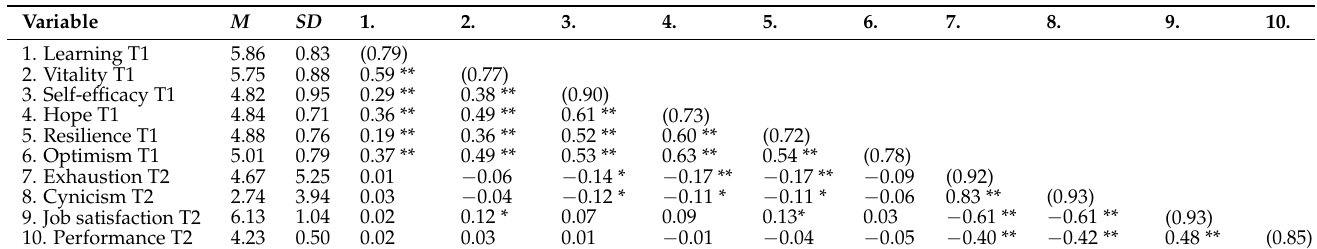
Table 1. Means, standard deviations, and correlation coefficients between variables.